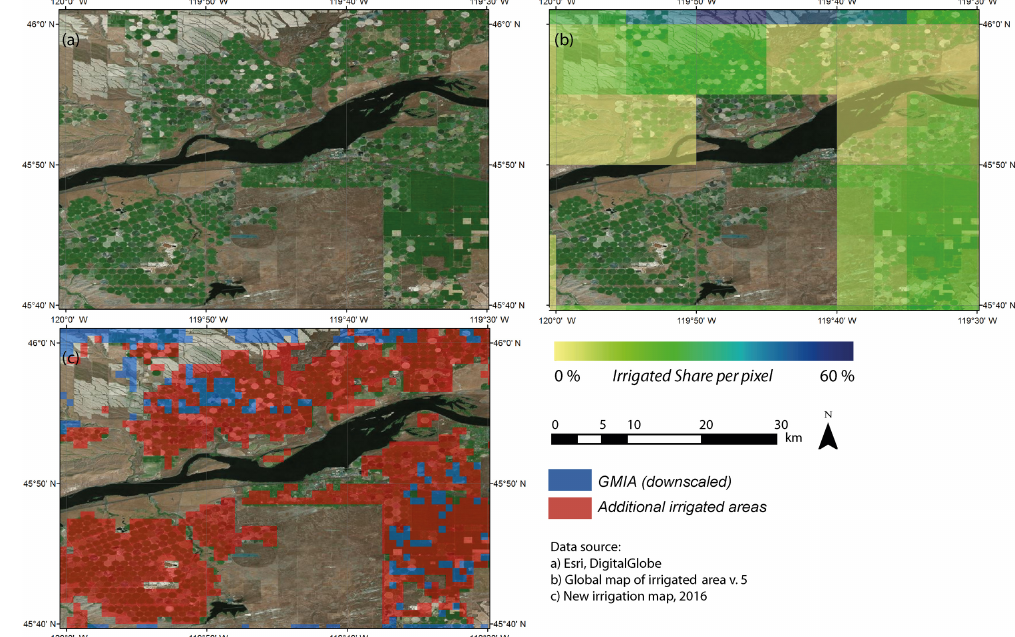
Figure 8. Small-scale analysis of the new irrigation map (c) and GMIA (b) in the USA compared to the raw satellite image (a)